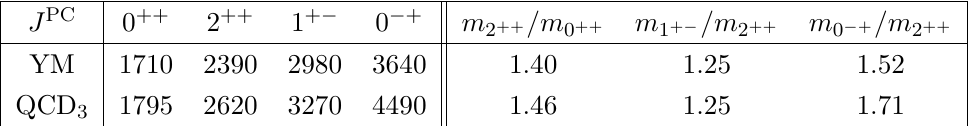
Table 2 . Comparison of the lattice glueball masses (measured in MeV) in the quenched Yang-Mills and QCD with three flavors [18]. The ratio of the masses of m 1 . 40 and 1 . 46